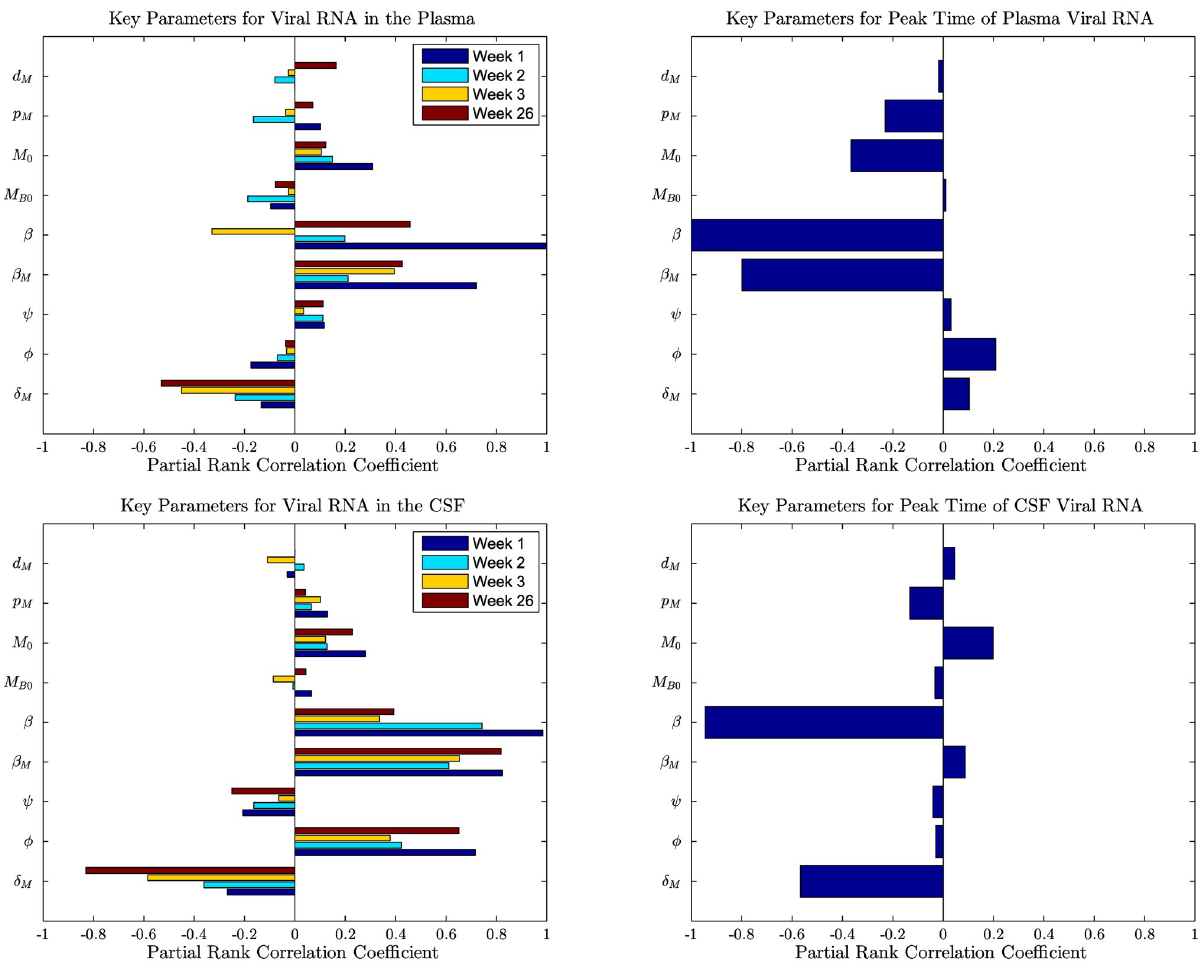
Fig 8. Partial rank correlation coefficients from the Latin hypercube sampling method. PRCC values of the plasma (top, left) and the CSF (bottom, left) viral loads at weeks 1 (pre-peak), 2 (peak), 3 (post-peak), and 26 (set-point) post infection along with the PRCC values of the timing of the peak viral loads in the plasma (top right) and in the CSF (bottom